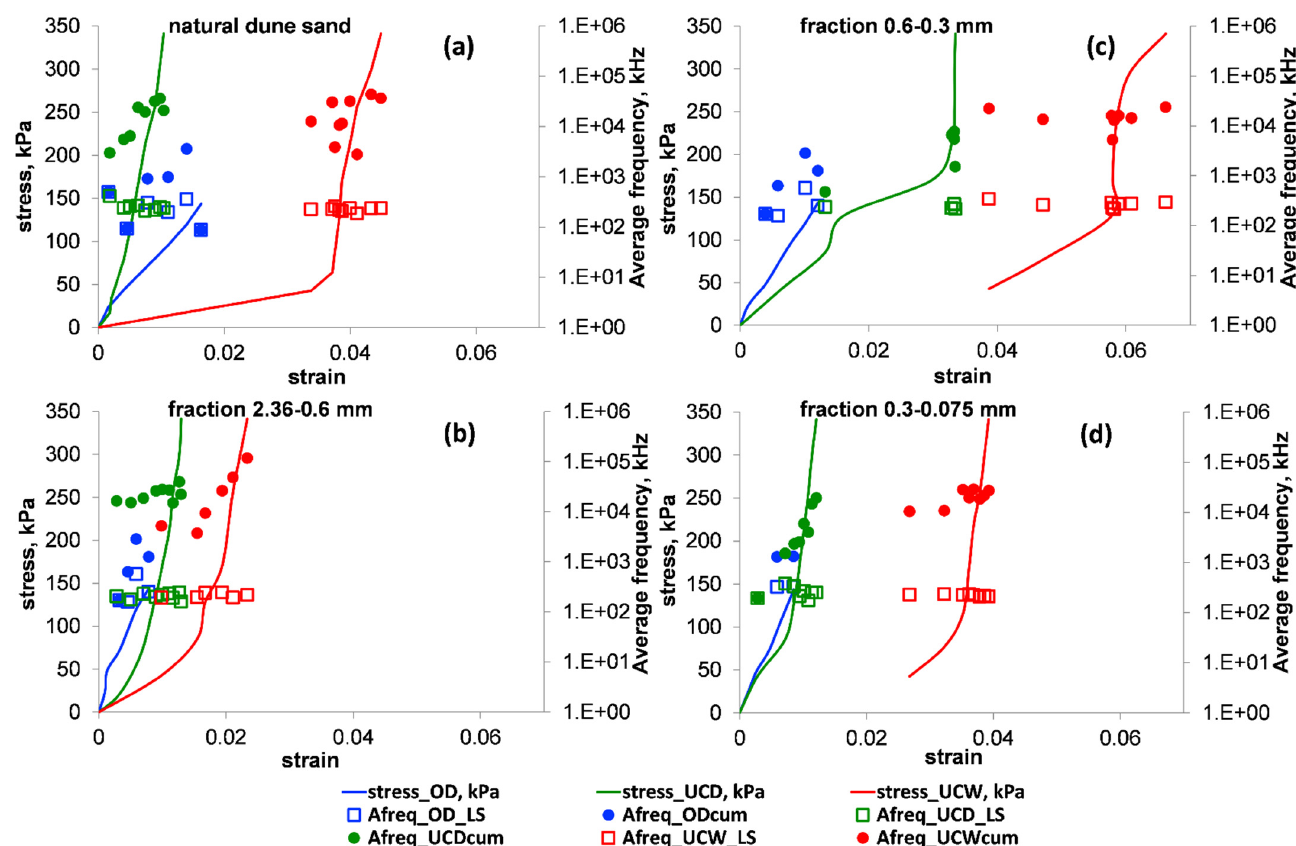
Figure 13. The stress–strain relationships (solid curves) vs. the values of the signal average frequency (Afreq) for the OD (blue), UCD (green) and UCW (red) tests. The empty squares and the full circles denote the values of the average (index = LS) and cumulative (index = cum) signal average frequencies for a load stage, respectively. Panels ( a – d ) illustrate the results for natural dune sand and its three extracted fractions: 2.36–0.6, 0.6–0.3 and 0.3–0.075 mm, respectively. Note that in the used number format, the notation “E ± xx” is part of a scientific notation and corresponds to “ · 10 ± xx